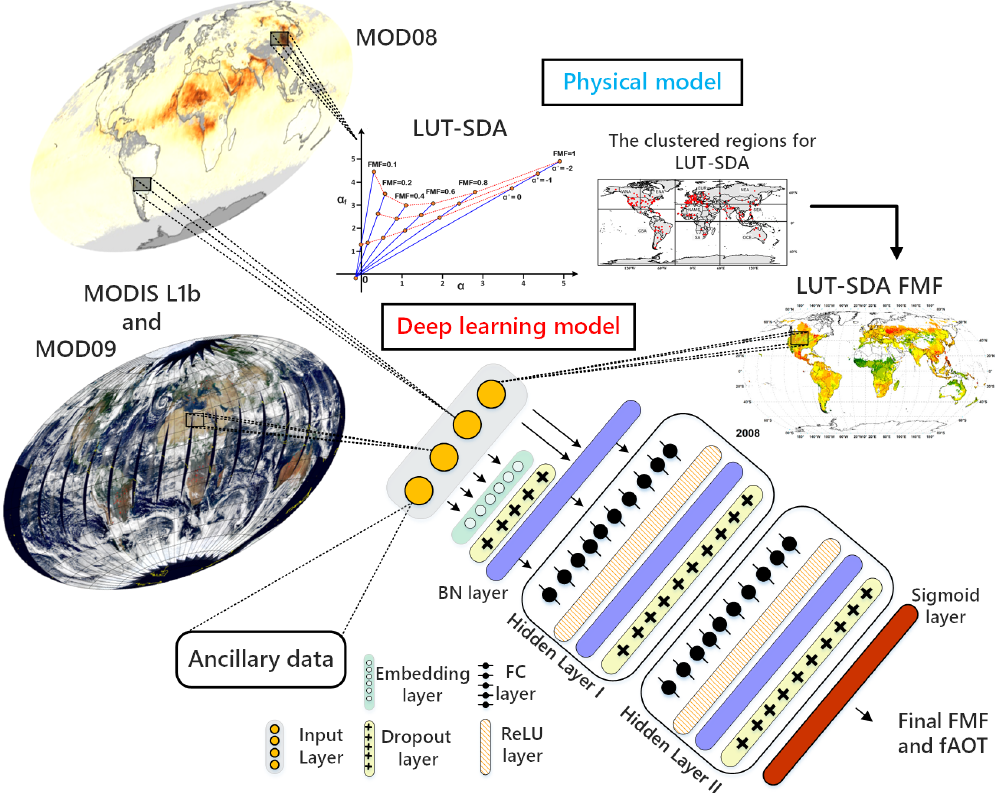
Figure 3. Technical flowchart for the production of the global land FMF product. The satellite true-color image composites of data from three wavelengths measured by the MODIS (a red band, a green band, and a blue band data from MODIS C6.1 L1B